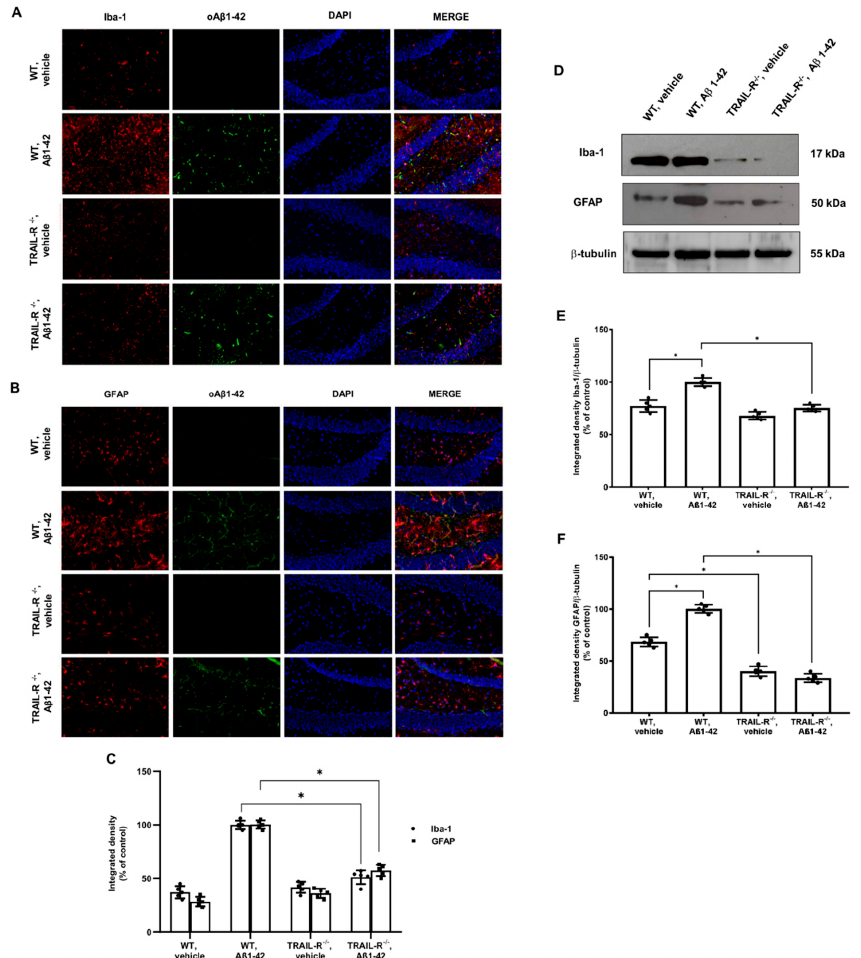
Figure 7. GFAP and Iba-1 are significantly reduced in the hippocampus of TRAIL-R − / − mice treated with oligomeric A β 1-42. Representative images (original magnification 20 × ) of the fluo- rescent immunohistochemical detection of ( A ) Iba-1 and oA β 1-42; ( B ) GFAP and oA β 1-42 expres- sion in WT and TRAIL-R − / − mice following stereotaxic infusion of oligomeric A β 1-42 or vehicle. ( C ) Densitometric analysis of Iba-1 and GFAP immunofluorescence signal. ( D ) Western blot analysis of Iba-1 and GFAP in WT and TRAIL-R − / − mice following stereotaxic infusion of oligomeric A β 1-42 or vehicle. ( E , F ) are respective densitometric analysis of the western blots. Data are expressed as means ± SEM. One-way ANOVA and the Bonferroni post-hoc test were used to determine statistical significance. * p < 0.05. N = 5 animals for each